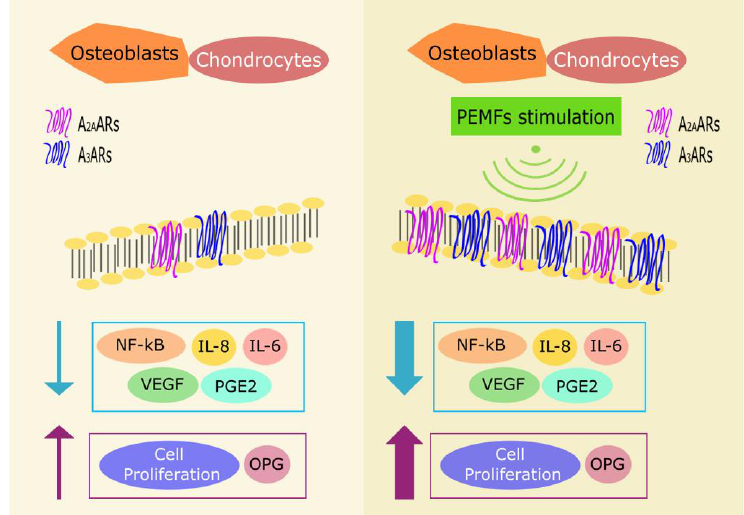
Figure 1. Effect of PEMFs on human osteoblasts and chondrocytes (no PEMFs: left panel, PEMFs exposure: right panel). PEMF stimulation induces an increase of A 2A and A 3 ARs expression. The PEMF-induced upregulation enhances the anti-inflammatory downstream receptors signaling by decreasing NF-κB activation and the release of inflammatory mediators, such as IL-6, IL-8, and PGE2. Besides, PEMF-induced modulation of A 2A and A 3 ARs results in a reduced VEGF release and increased cell proliferation and OPG production.